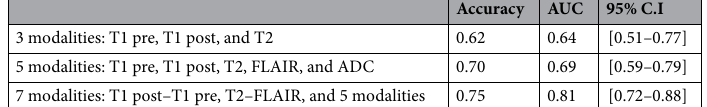
Accuracy AUC 95%